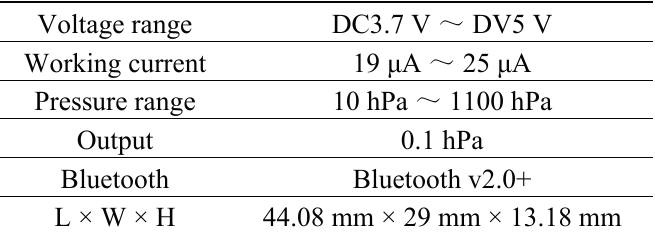
Table 2. WTZ809A features.